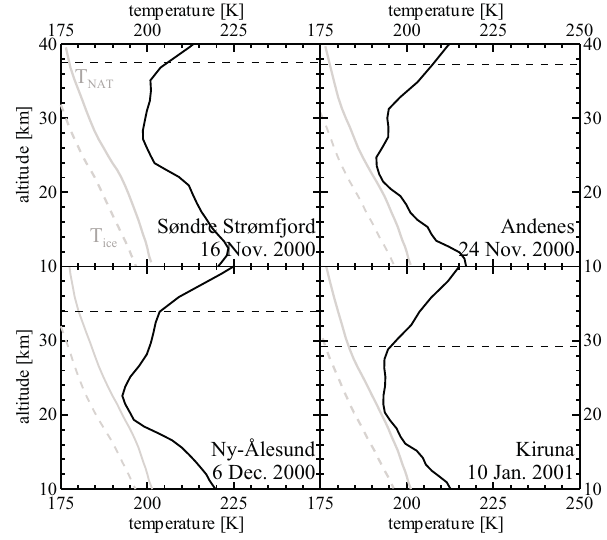
Fig. 7. Temperature profiles from ECMWF data for the observa- tions of the aerosol layer displayed in Fig. 2. T ice and T NAT (for 4.6 ppmv H 2 O) are marked grey dashed and outlined, respectively. The horizontal dashed lines show the altitude of the aerosol